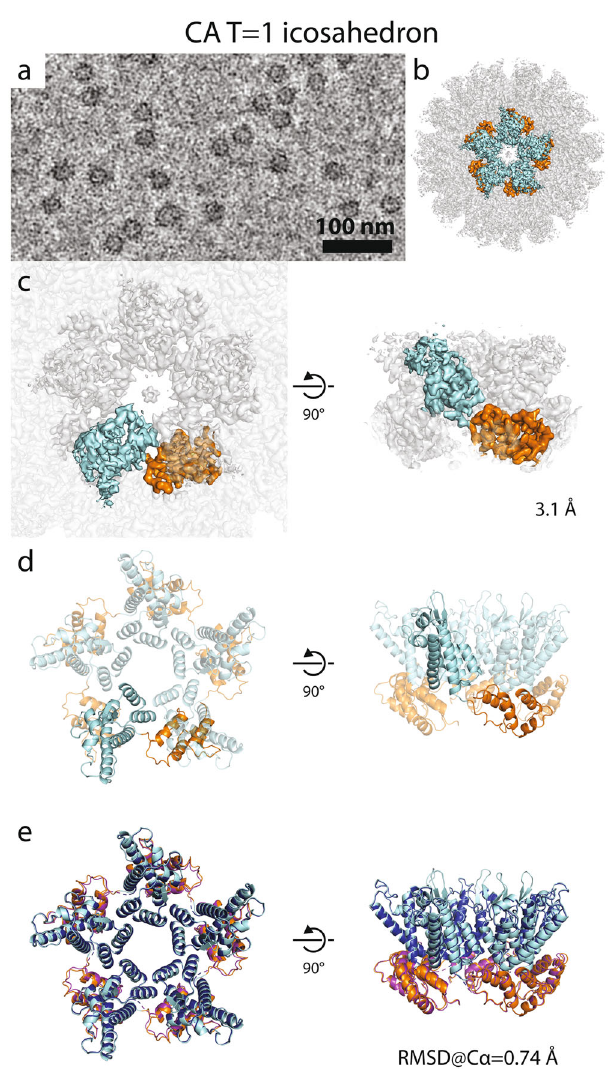
Fig. 5 Structure of the RSV T = 1 icosahedron pentamer. a Filtered cryo- EM micrograph of T = 1 icosahedrons. The image is representative of the 2394 micrograph dataset. b Isosurface representation of the CA T = 1 icosahedron determined by single-particle cryo-EM. One pentamer is highlighted in colors: cyan — CA NTD ; orange — CA CTD . c Isosurface representations of one T = 1 pentamer from the structure shown in b . The density in the center of the petamer, coordinated by K17 and R21, may correspond to phosphate ions, which are the main negatively charged component of the assembly buffer. d Model of the RSV CA pentamer re fi ned from the structure shown in b . e Comparison of the real-space re fi ned model of the CA pentamer from T = 1 particles and rigid-body fi tted model of CA pentamer from polyhedrons. The low RMSD value of their backbone atoms shows that the two models are almost